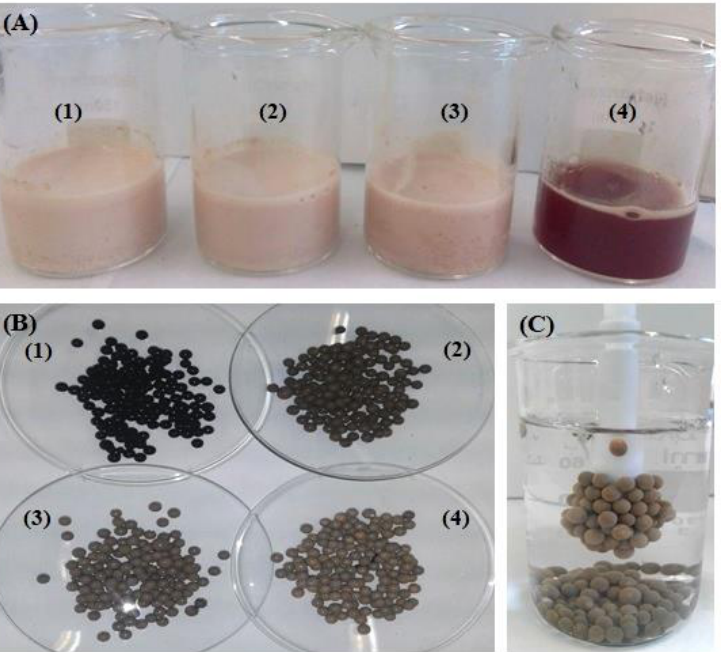
Figure 7. ( A ) Chitosan gel/Fe 3 O solutions. ( B ) Wet chitosan beads at a molar ratio TiO 2 /Fe: ( 1 ) 0; ( 2 ) 1; Figure 7. ( A ). Chitosan gel / Fe 3 O solutions ( B ). Wet chitosan beads ata molar ratio TiO 2 /Fe: ( 1 ) 0; ( 2 ) ( 3 ) 2 and ( 4 ) 3. ( C ) Superparamagnetic behavior of the TiO 24 -CS beads at a molar ratio TiO 2 /Fe = 2. 1; ( 3 ) 2 and ( 4 ) 3/ ( C ). Superparamagnetic behavior of the TiO 24 -CS beads ata molar ratio TiO 2 /Fe = 2.